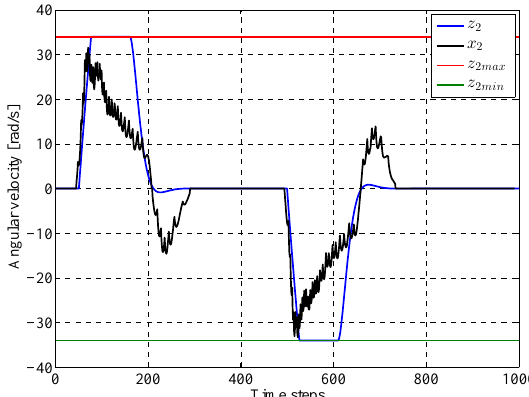
Figure 4: The angular velocity z 2 of the nominal model, and x 2 of the real plant for the nom-